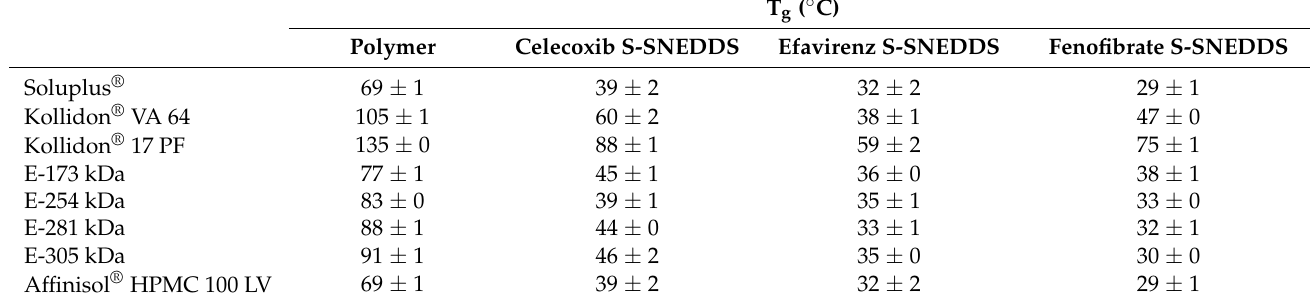
Table 5. Glass transition temperature (T g ) of the pure (co)polymers and S-SNEDDS incorporating celecoxib, efavirenz, or fenofibrate after six months of storage. Each value designates the mean ± S.D. ( n =